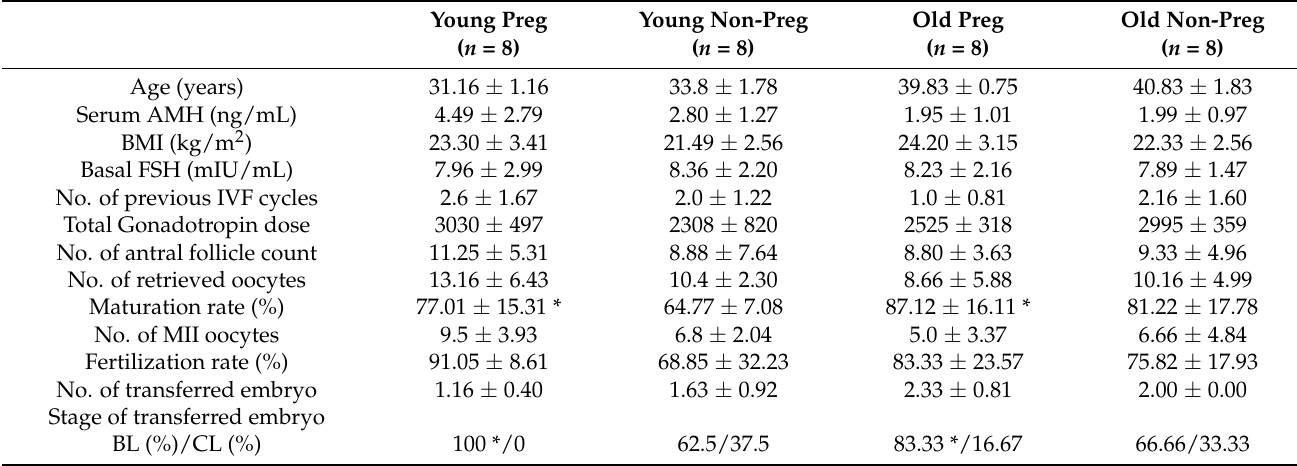
Table 1. Patients’ characteristics and oocyte profiling of women in the young and old groups, with or without pregnancy. BL: blastocyst, CL: cleavage stage embryo. Significant differences are indicated by asterisks (* p < 0.05).